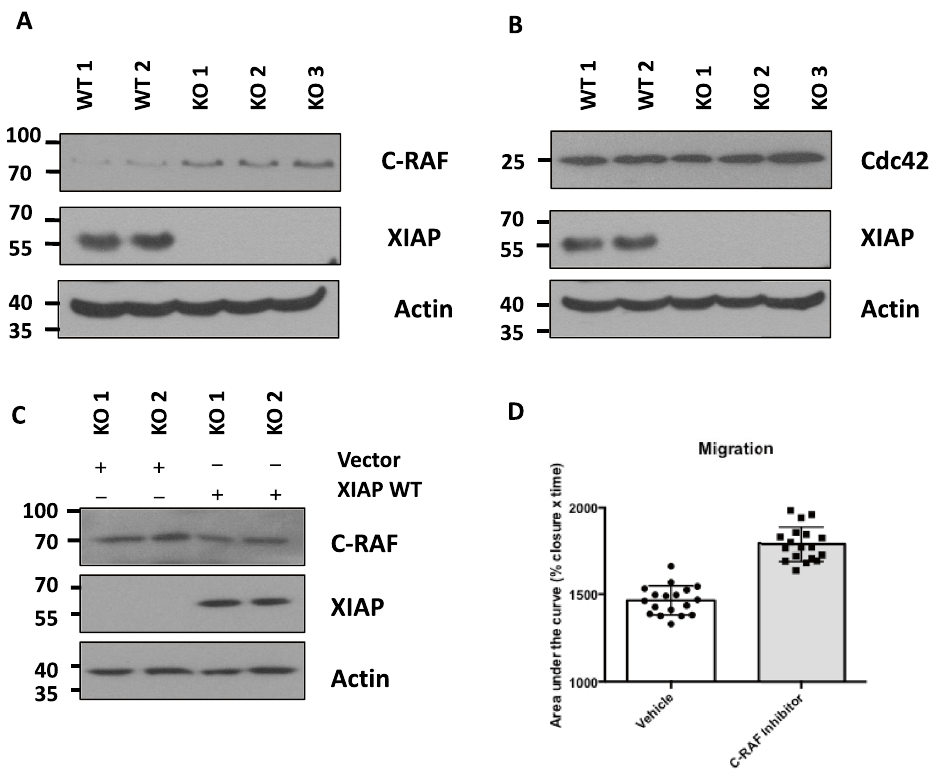
Figure 6. XIAP controls levels of C-RAF to influence cell migration. ( A , B ) Whole cell lysates were prepared from CRISPR/Cas9 monoclonal U2OS cells and immunoblotted using the indicated antibodies. ( C ) XIAP KO U2OS cells were transfected with XIAP or empty vector. Whole cell lysates were prepared and immunoblotted using the indicated antibodies. ( D ) The area of the wound of XIAP null cells (KO 2) treated with the C-RAF inhibitor, BAY 43–9006, was imaged and measured at 0, 8, and 24 h using ImageJ software. The data was normalised with the percentage wound area equalling 100% at 0 h. Each measurement represents data from an individual scratch (6 technical repeats of 3 independent experiments). The % wound area was plotted against time and the area under the curve (% wound area × time(hours)) was calculated and analysed by unpaired students